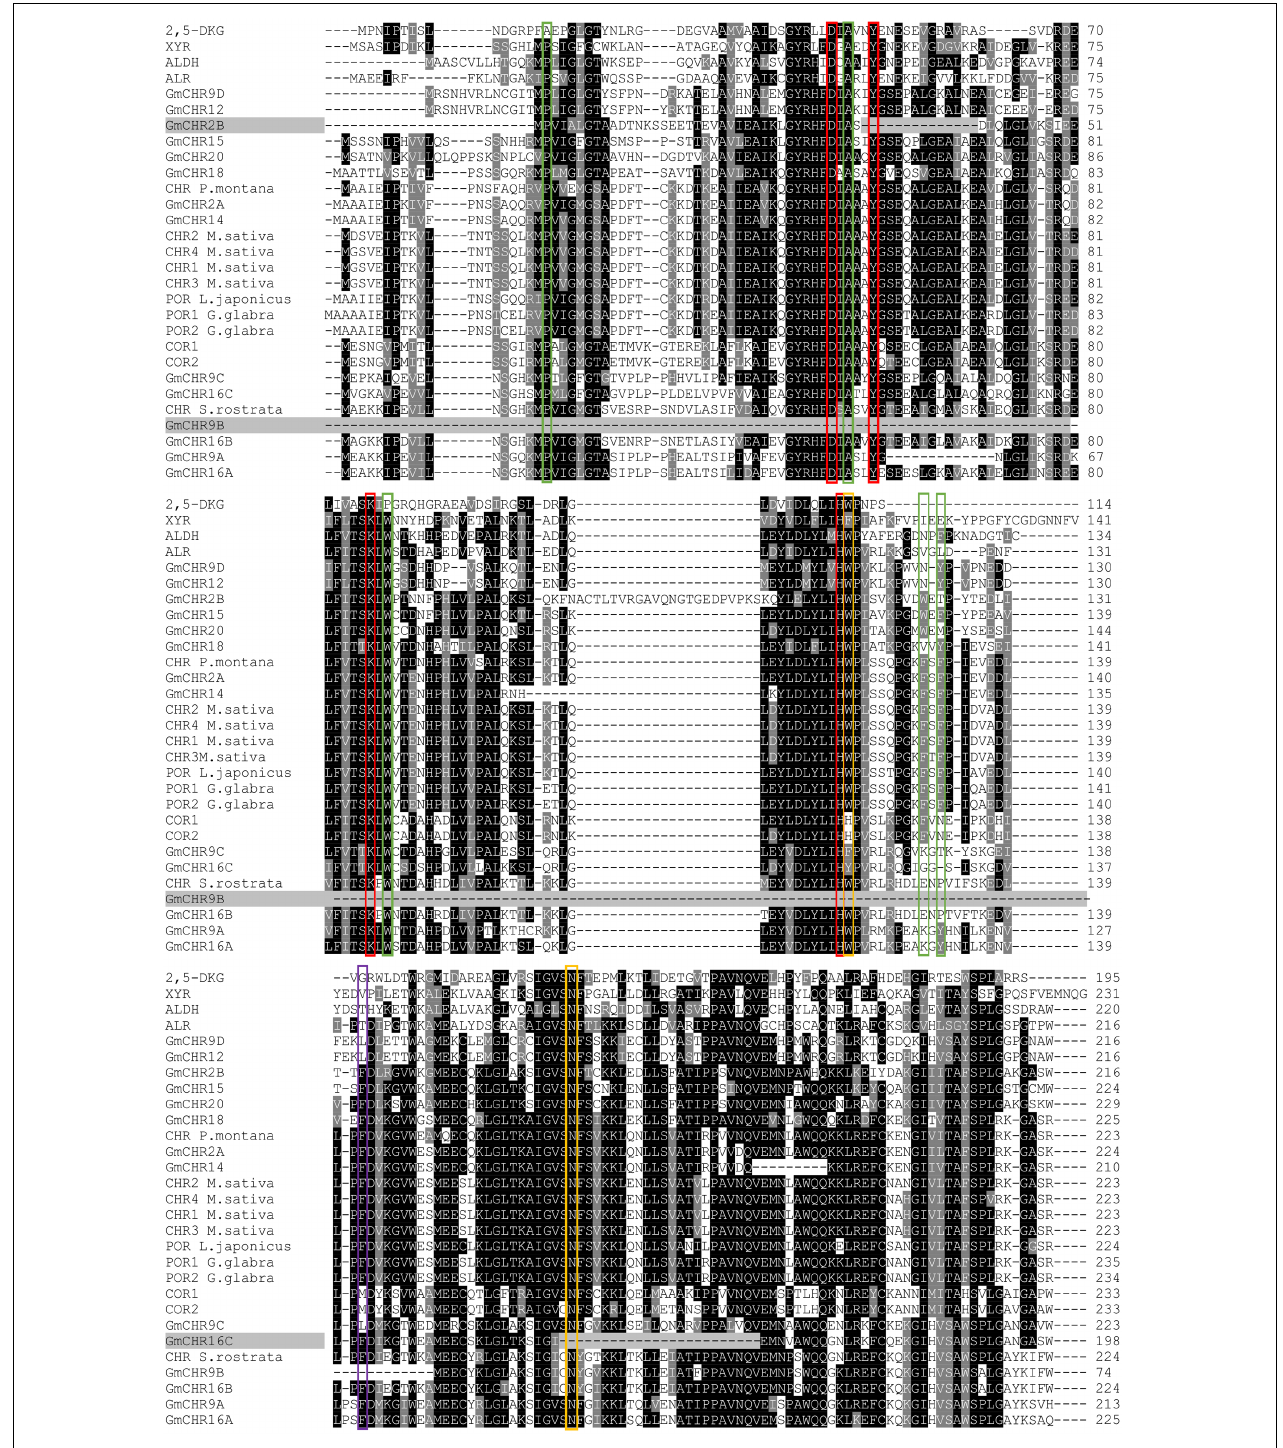
FIGURE 3 | Identification of important amino acid residues in putative GmCHRs. Candidate GmCHRs obtained from the phylogenetic analysis were aligned using CLUSTALO with other known AKRs and CHRs from other plant species. Critical and other residues were noted: entrance of the catalytic site ( (cid:3) ), AKR catalytic tetrad ( (cid:3) ), unique amino acids from COR ( (cid:3) ), CHR active site with AKR catalytic tetrad ( (cid:3) ). GmCHRs which are missing critical residue are indicated through gray shading. Only an abridged version of the alignment is shown.